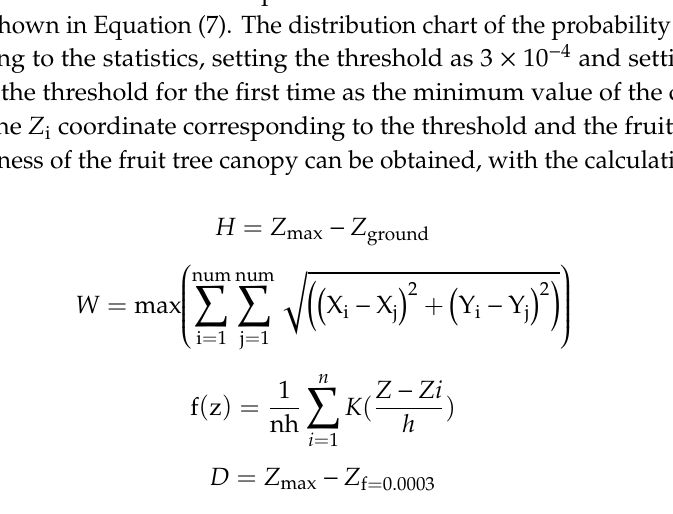
Figure 8. Schematic diagram of height and maximum width of fruit tree: ( a ) schematic diagram for the